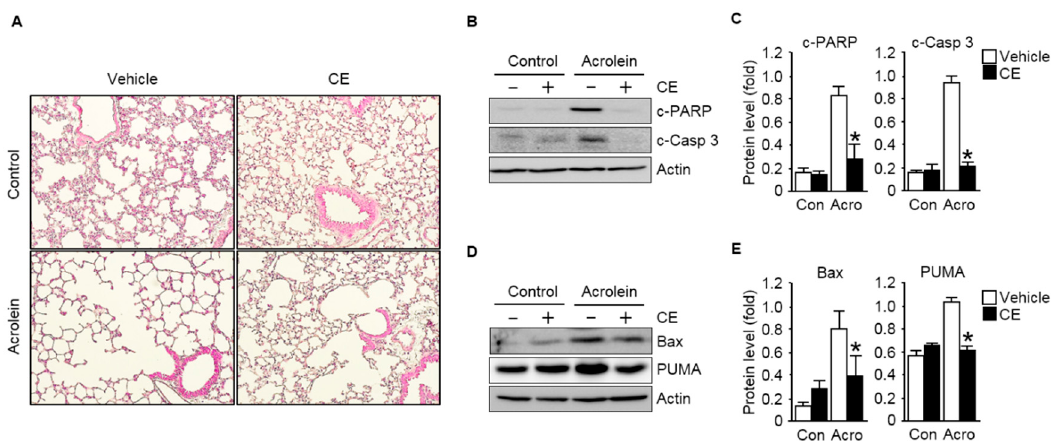
Figure 4. Protective e ff ect of CE against pulmonary apoptotic injuries of lung tissues exposed to acrolein. Mice were exposed to filtered air or 10 ppm acrolein for 12 h. CE (200 mg / kg) was orally administered to mice once per day for 10 days prior to acrolein exposure. ( A ) Morphometric appearance of pulmonary tissues. H&E staining was carried out to exam the lung sections. Microscopic observations were conducted at 20 × magnification; ( B ) immunoblot data comparing the levels of the apoptotic marker proteins c-PARP and c-Casp 3 in lung tissue extracts from mice. Actin was used as the loading control; ( C ) quantifications of the levels of c-PARP and c-Casp 3 normalized to those of actin are shown; ( D ) immunoblot analysis of apoptosis-related signal proteins in lung extracts exposed to acrolein with or without pre-treatment with CE. The immunoblot of actin was included as the loading control; and ( E ) the quantifications of the pro-apoptotic proteins BCL2-associated X (Bax) and p53 upregulated modulator of apoptosis (PUMA) normalized to those of actin are shown. Each value is presented as the mean ± S.D. from three to six independent experiments. * p < 0.05 versus acrolein-treated group. Con, control; Acro, acrolein.